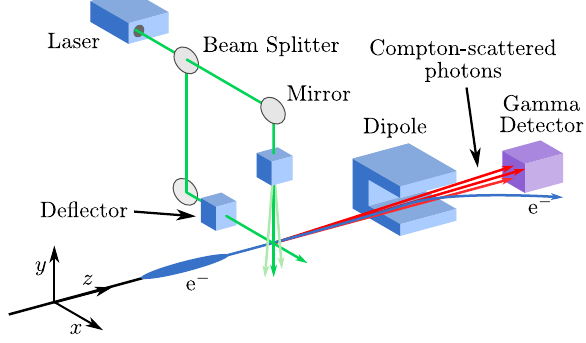
FIG. 1. Conceptual schematic of a laserwire. A laser beam is scanned perpendicularly to an electron beam producing Comp- ton-scattered photons that are detected after a dipole magnet.